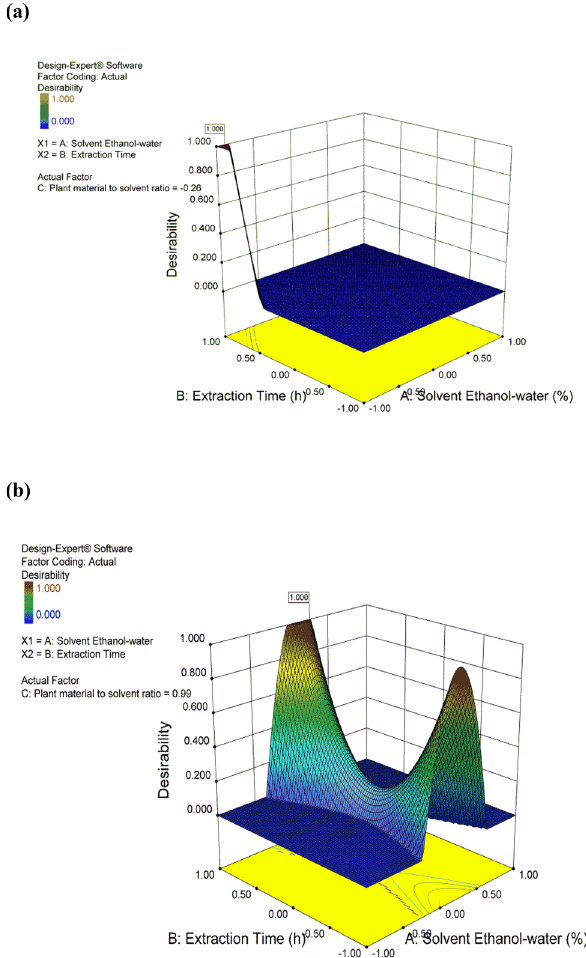
Figure 6. Desirability 3D plots for the optimized extractions. ( a ) (Opt.1) Yield ( b ) (Opt.2) Phenolic content.